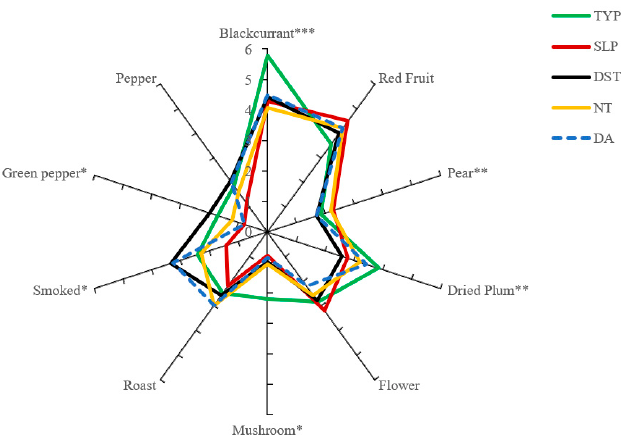
Figure 1. Aroma spider graphs of the sensory characteristics of Cabernet Sauvignon wine, obtained using 12 panelists with wines analyzed in triplicate. Asterisks indicate significance at * p < 0.1, ** p < 0.05, *** p < 0.01. SLP, TYP, NT, DA and DST are the abbreviations for five young vineyards in the Loess Plateau region.